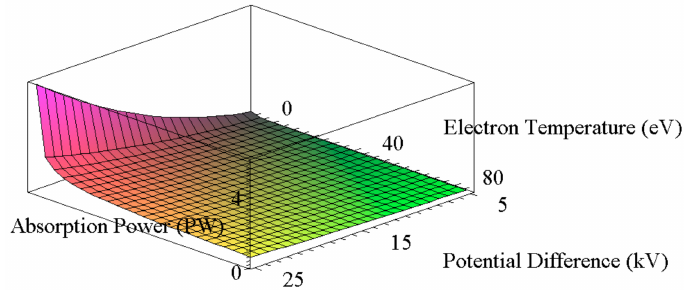
Figure 17. The 3D plot of the absorption power versus the electron temperature and the potential difference.